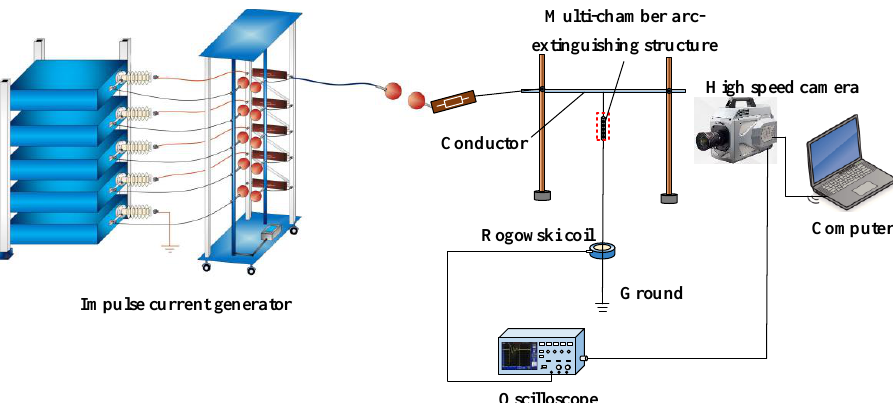
Figure 8. circuit diagram of impulse current test for the multi-chamber arc-extinguishing structure.